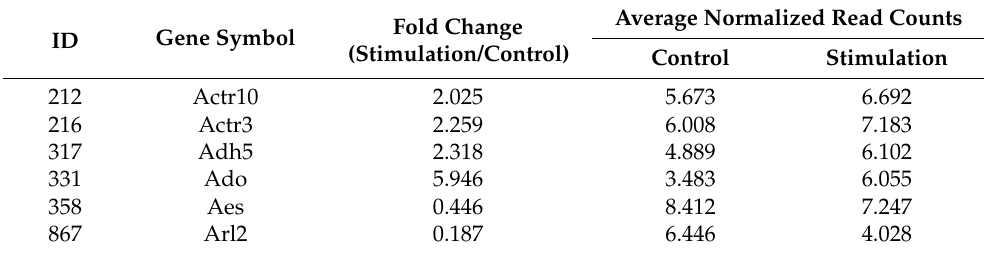
Table 1. Fold changes in 180 genes with significant fold